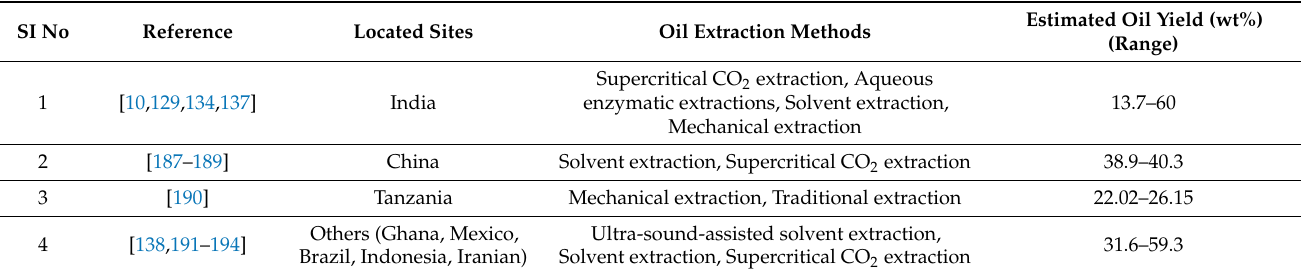
Table 7. The oil content of Jatropha seeds obtained from a variety of